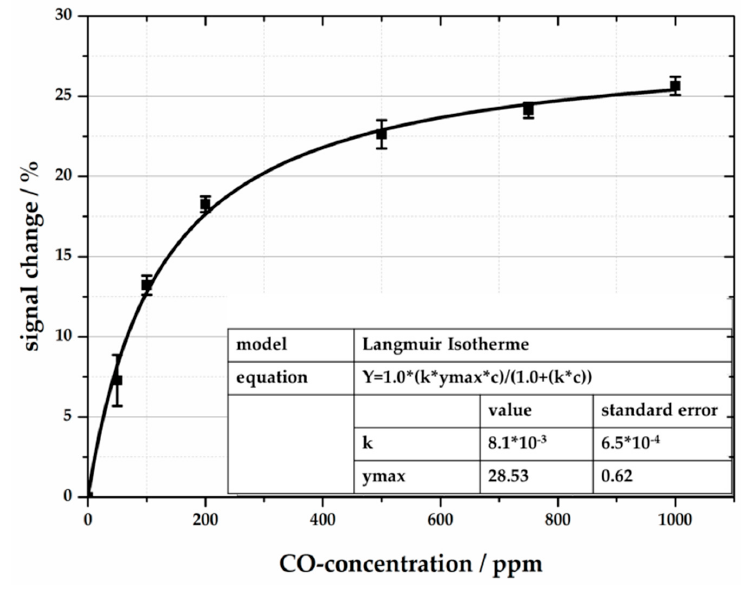
Figure 10. Calculated Langmuir isotherm for gasochromic CO reaction of the color dye. The reaction leads to signal changes up to leads to signal changes up to 28.53%.